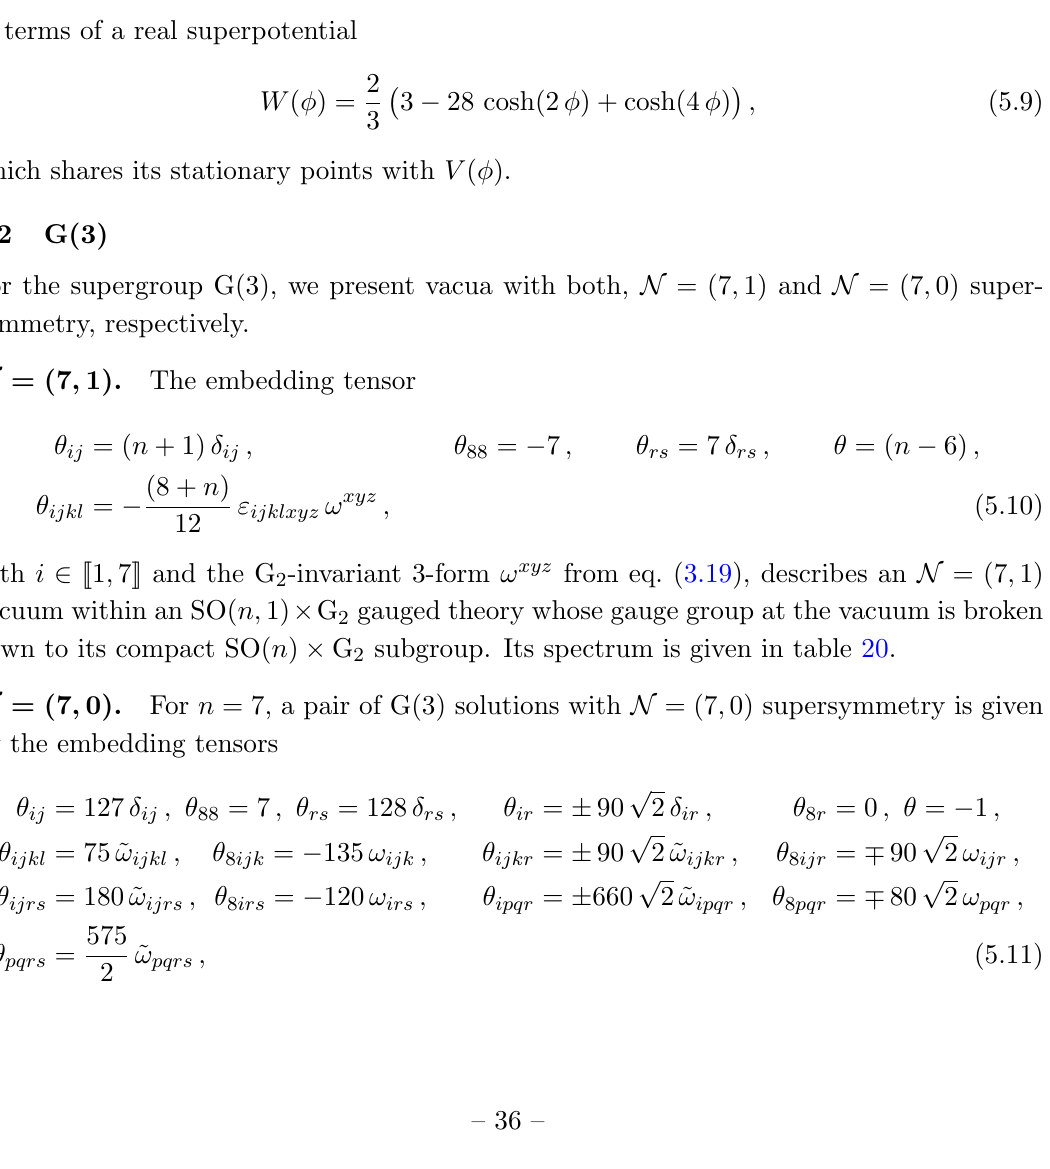
= (8 ; 0) supersymmetry, while the two N